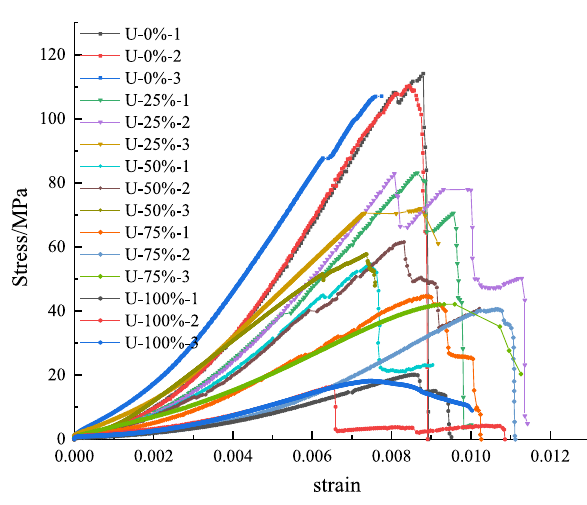
Fig. 6 Stress path of the cyclic loading–unloading